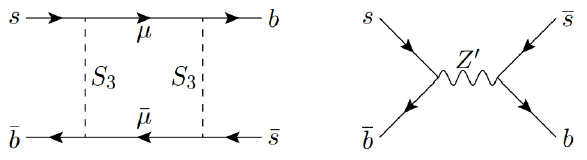
Figure 2 . Example leading order Feynman diagrams of beyond the SM contribution to B s − B s mixing via the S 3 leptoquark (left panel) or the B 3 − L 2 Z 0 model (right panel). Z 0 explanations. Because the Z 0 model predicts tree-level contributions to ∆ M